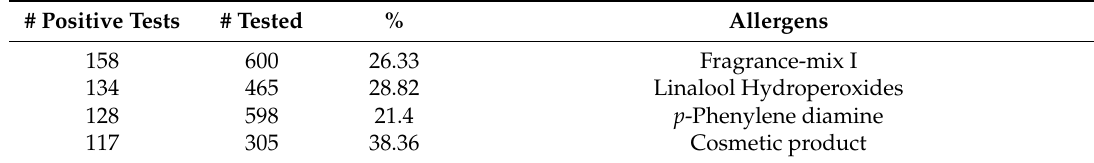
Table 2. Cosmetic allergens identified during the period 2010–2015 among 603 patients suffering from cosmetic dermatitis (iatrogenic dermatitis